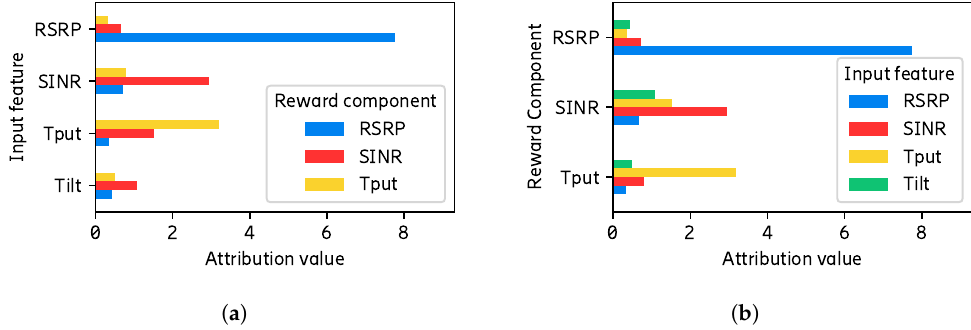
Figure 5. Explanations generated using BEERL at the Q-functions level without applying rewards prioritization. ( a ) Decomposed feature importance at the Q-function level. ( b ) Decomposed feature importance presented per reward component at the Q-function